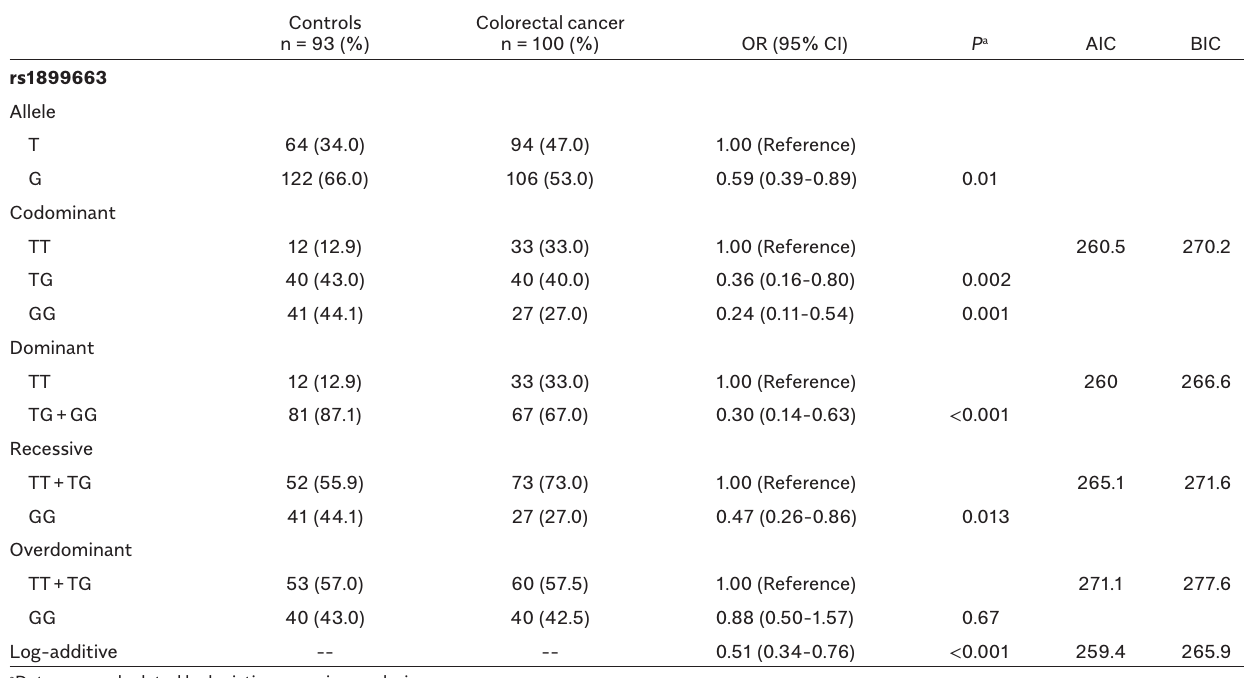
Table 2. Allele and Genotype Frequencies in the Colorectal Cancer Cases and the Healthy Control Groups As Well As the Association of HOTAIR rs1899663 T > G Polymorphism with the Risk of Colorectal Cancer Susceptibility According to Different Models of Inheritance